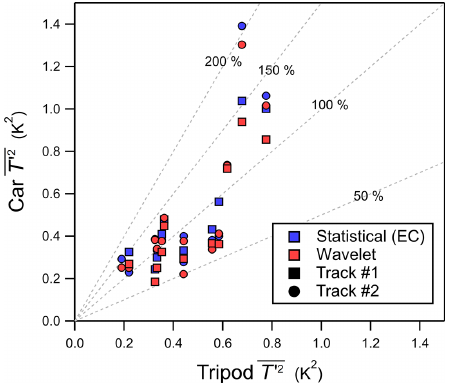
Figure 9. The sonic temperature variance, T (cid:48) 2 , measured by the tripod (horizontal) and compared to the mobile car (vertical). Co- variances calculated using wavelet analysis and eddy covariance are shown as red and blue markers, respectively. Dashed gray lines de- note constant percentages of the independent